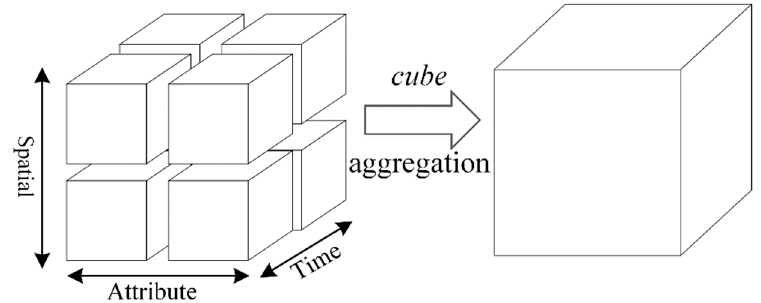
Figure 1. Cube aggregation operations of the S × T × A cube.